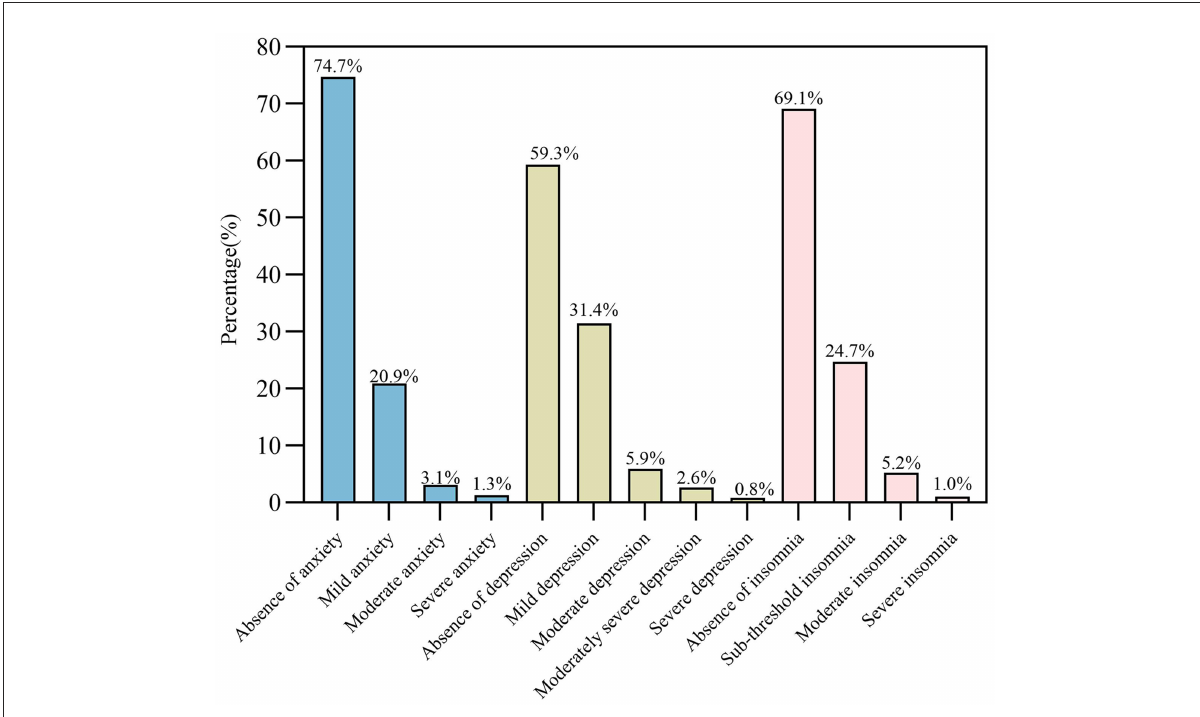
FIGURE1 Severity levels of anxiety, depression and insomnia among